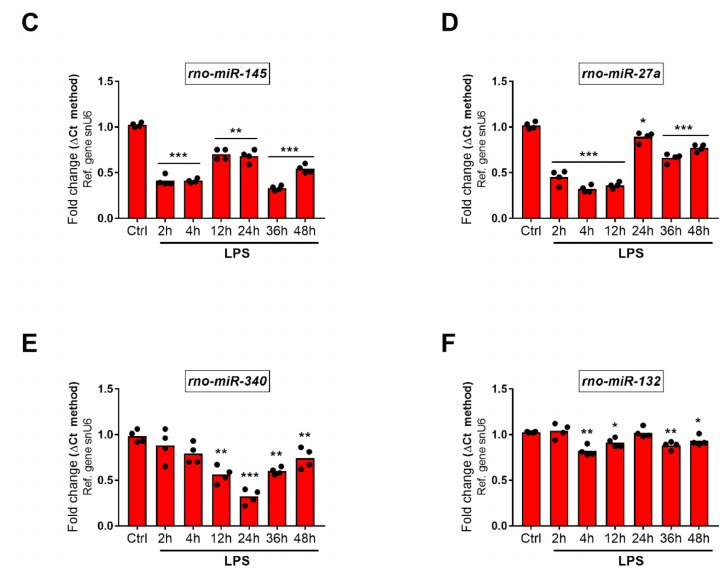
Figure 5. Time-course analyses of downregulated miRNAs following LPS exposure. ( A ) Heatmap showing the overall pattern of expression of the dysregulated miRNAs over time. Each bar graph depicts the expression profile of ( B ) rno-miR-181b ; ( C ) rno-miR-145 ; ( D ) rno-miR-27a ; ( E ) rno-miR-340 and ( F ) rno-miR-132 after treatment with 1 µ g/mL LPS at different time points (0, 2, 4, 12, 24, 36 and 48 h). Ctrl = time 0. Data shown are the mean fold change ± SEM, obtained from two independent experiments, each performed using separate biological replicates ( n = 4). * p < 0.05, ** p < 0.01 or *** p < 0.001 vs. Ctrl; repeated measures ANOVA followed by Fisher’s LSD